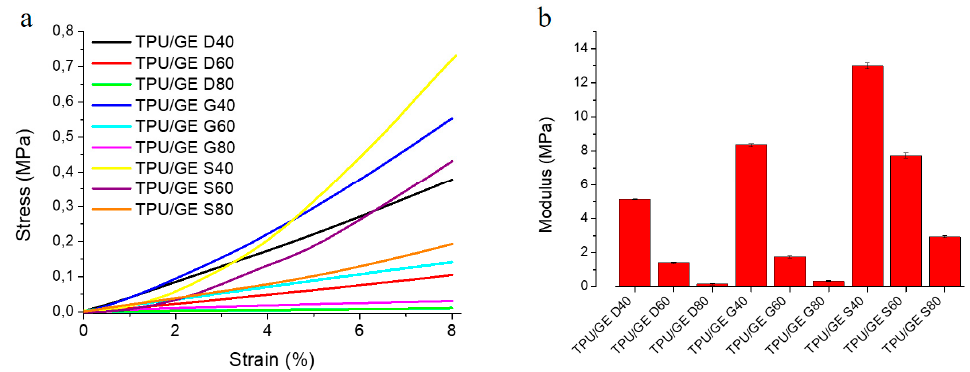
Figure 6. ( a ) Compression stress-strain curves, and ( b ) compression elastic modulus of the SLS fabricated TPU/GE porous structures.